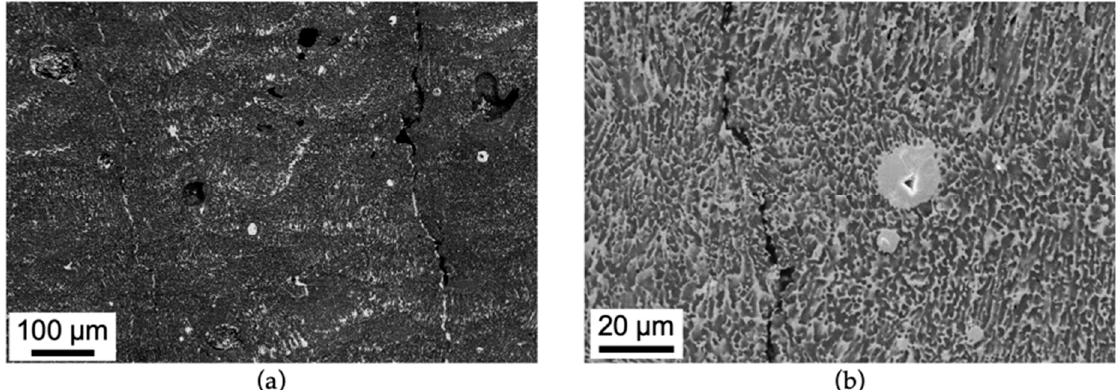
Figure 9. SEM micrographs (BSE) of sample I ( a ) and sample E ( b ) showing cracks at different orders of magnitude.